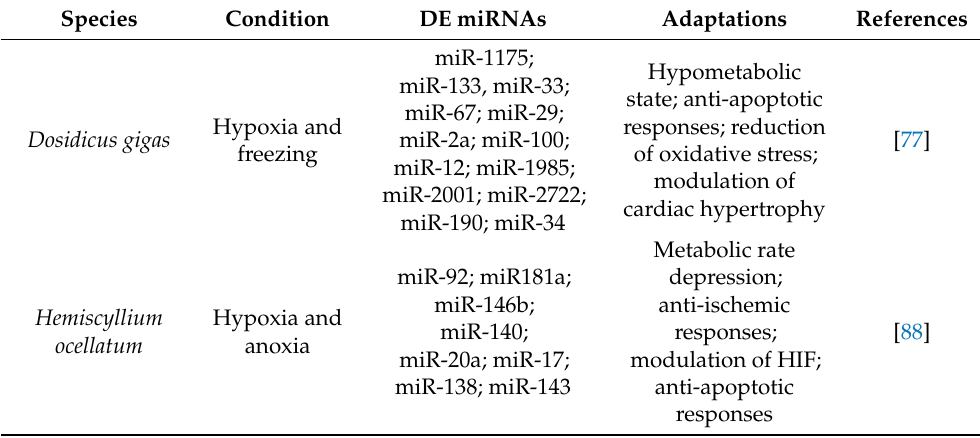
Table 1. Differential expressed (DE) miRNAs of marine species under different extreme conditions and relative